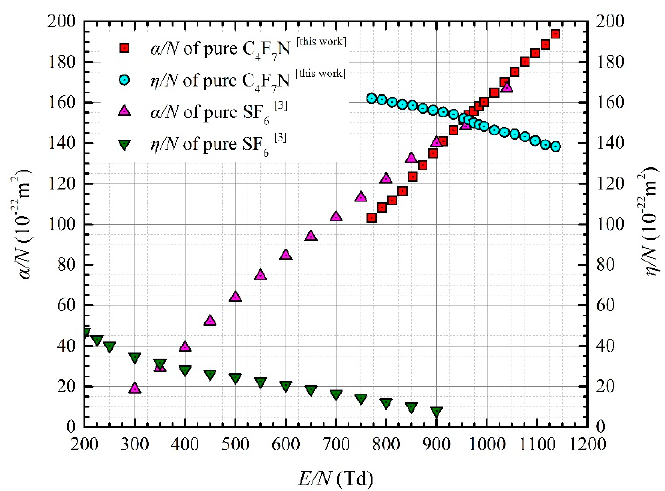
Figure 1. Values of α /N and η /N as a function of E/N in C 4 F 7 N gas in the present work and their comparison to SF 6 gas.